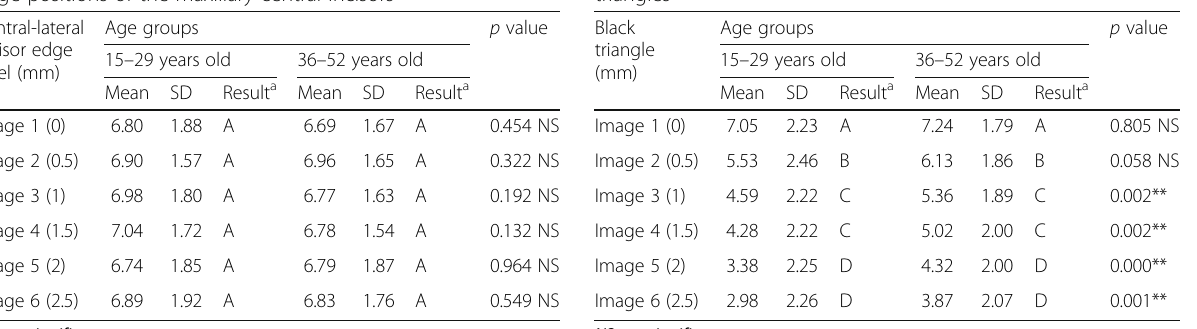
Table 4 Photograph ratings by age group of altered